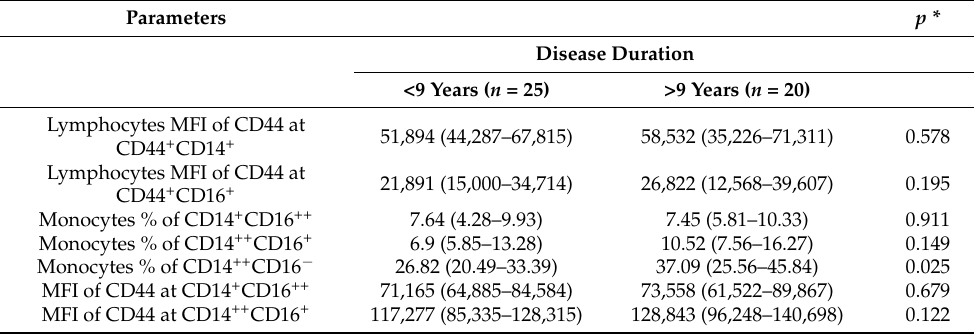
Table 1. Comparison of selected parameters between IBD subgroups according to median of disease duration.